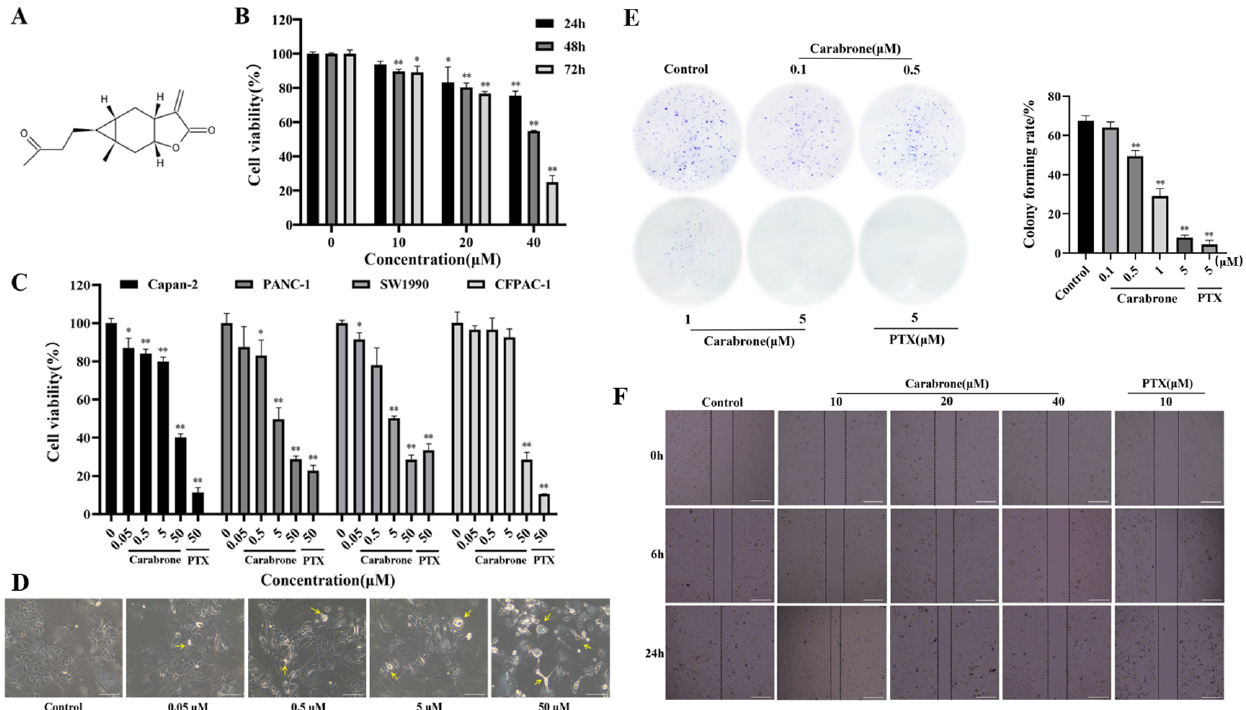
Figure 1. Effect of carabrone on cell viability, proliferation, morphology and migration in SW1990 cells. ( A ) Chemical structure of carabrone. ( B , C ) SW1990, CFPAC-1, Capan-2 and PANC-1 cells were evaluated with carabrone to detect cell viability by MTT assay. ( D ) Observation of cell morphology of SW1990 cells treated with carabrone. Damaged cells are indicated by yellow arrows. ( E ) Image of colony formation. Colony forming rate = (number of colonies/number of cells inoculated) × 100% ( F ) Effect of carabrone on wound healing assay of SW1990 cells. Data are presented as mean ± SD ( n = 3). * p < 0.05, ** p < 0.01, compared with the control.